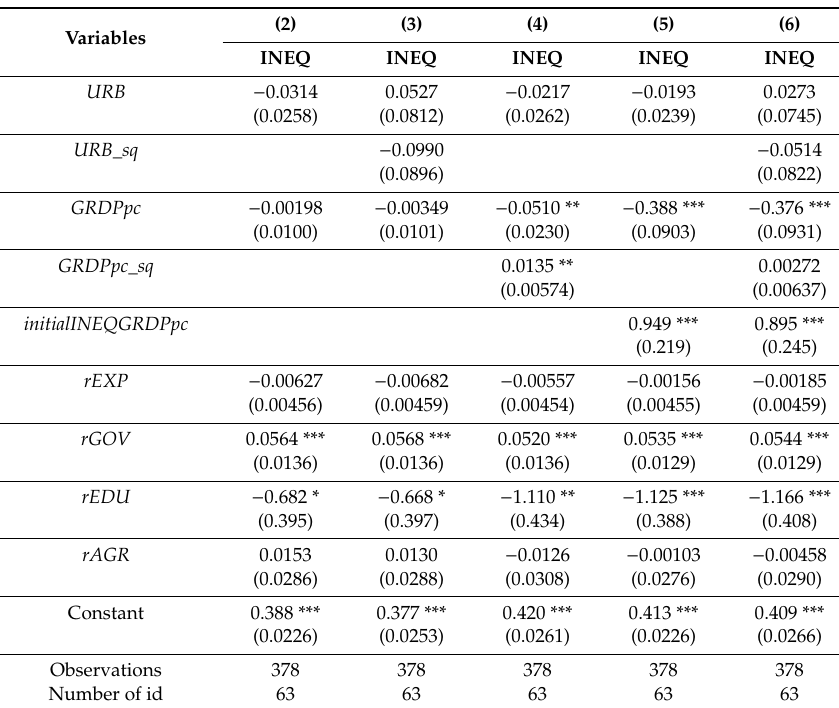
Table A2. Results of RE